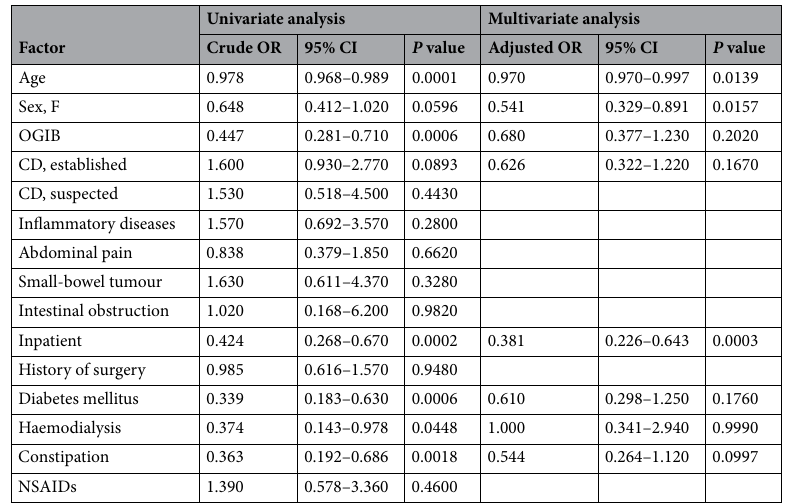
Table 3. Univariate and multivariate logistic regression analyses of factors associated with excretion within 30 h. CD Crohn’s disease, CI confidence interval, NSAID nonsteroidal anti-inflammatory drug, OGIB obscure gastrointestinal bleeding, OR odds ratio.